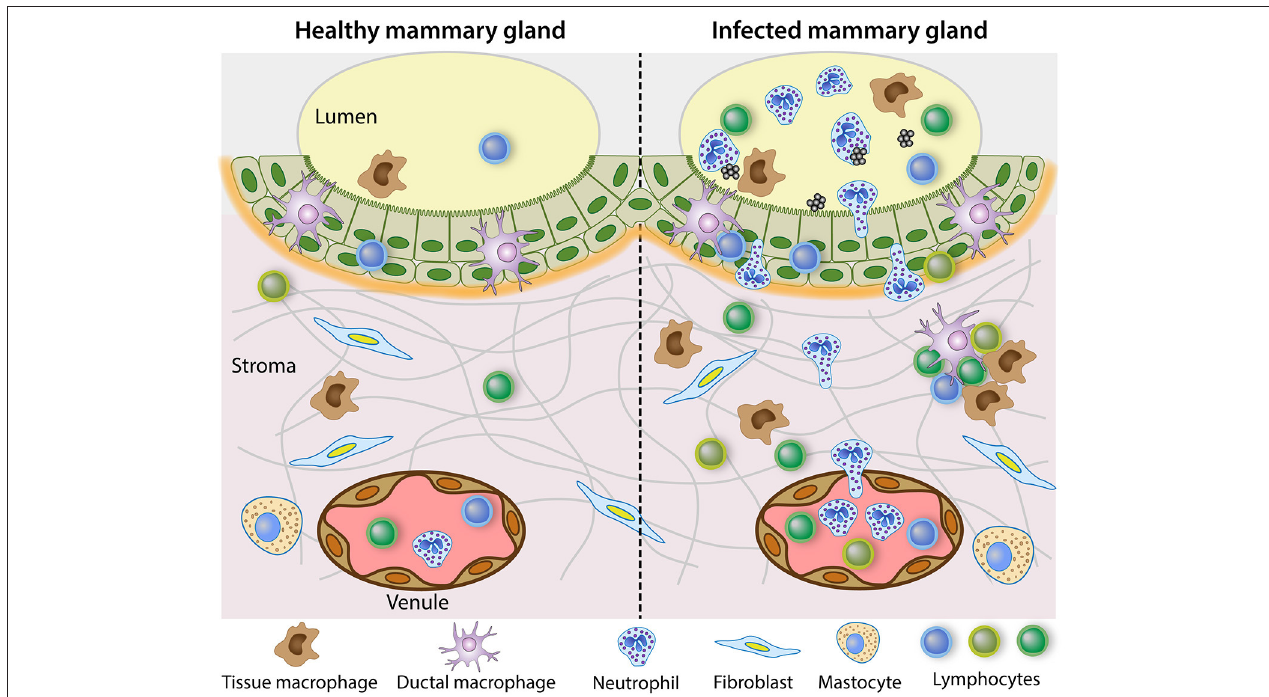
FIGURE 1 | Steady state immune system in the healthy mammary gland and reactive leukocytosis when infection occurs. The healthy lactating mammary gland is relatively poor in leucocytes, in the lumen but also in the tissue. The mammary epithelium schematized in the figure is the bilayer epithelium of the cisterns and large ducts. It is populated with ductal macrophages and a few lymphocytes, mainly CD8 pos T cells. In the sub-epithelial stroma, which is richly vascularized, a few lymphocytes, mainly CD4 pos T cells are scattered along with stromal macrophages. By contrast, the infected mammary gland recruits inflammatory cells, mainly neutrophilic granulocytes, and attracts monocytes and multiple types of lymphocytes. In chronic infections, lymphocytes aggregates and inducible tertiary lymphoid formations may